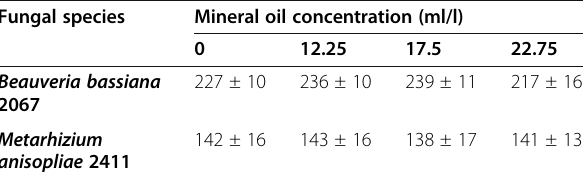
Table 6 Viability (colonies number) of the spores according to the different treatments with mineral oil Fungal species